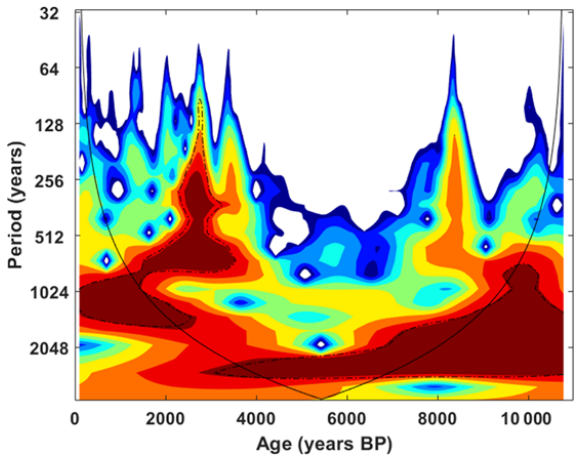
Figure 3. Change of the periodicity in the lithogenic mass accu- mulation rates (LIT MAR) record. Wavelet power spectrum for LIT MAR of SO90-63KA using a MATLAB Wavelet script (Torrence and Compo, 1998). The black line indicates the cone of influence and the dashed black line the 95% significance level. The peri- odicities clearly change in the time from 4.2ka to 3.5kaBP from ca. 2360 years during the Early and Mid-Holocene to ca. 590–710 and 1400 years during the Late